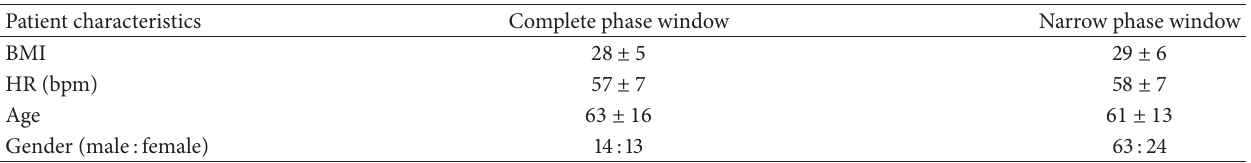
Table 1: Summary of patient characteristics for two groups undergoing imaging using complete versus narrow phase window acquisition at 320-row MDCTA.